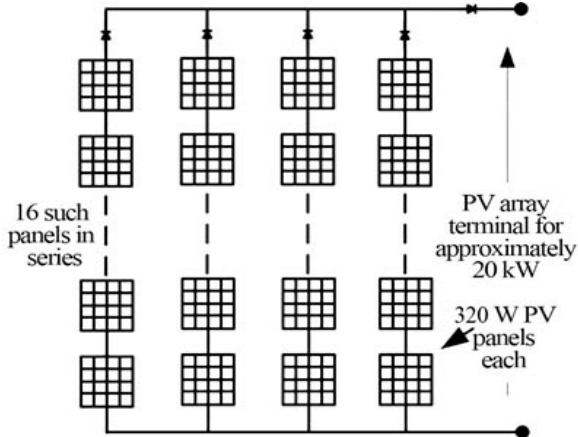
Figure 5. PV panel arrangement to make it an array of 20 kW. Table 1. Grenoble and Tehran mission profile.